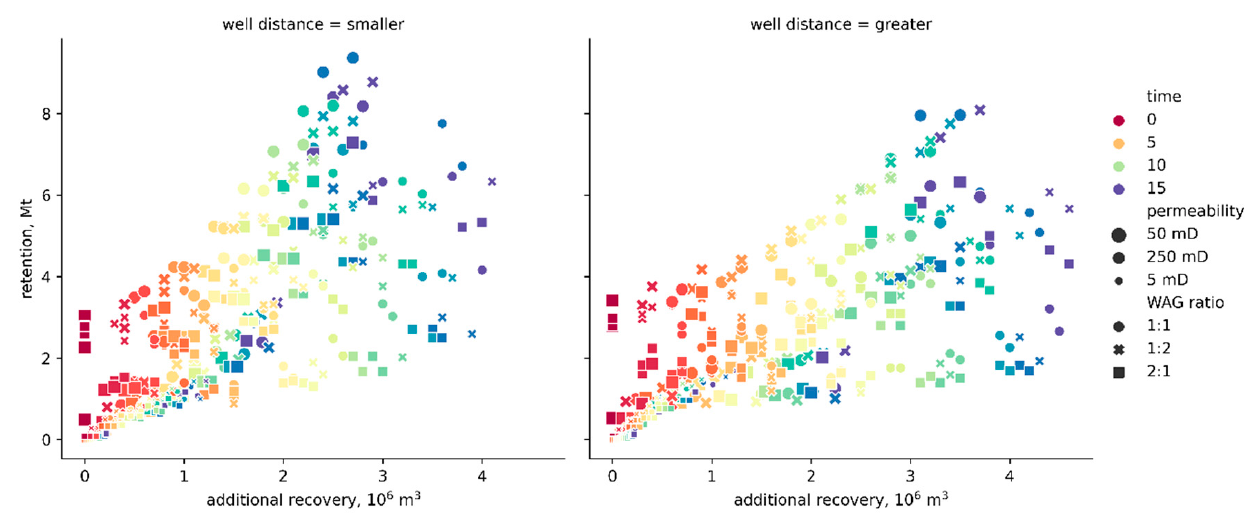
Figure 4 . Retention versus additional recovery.